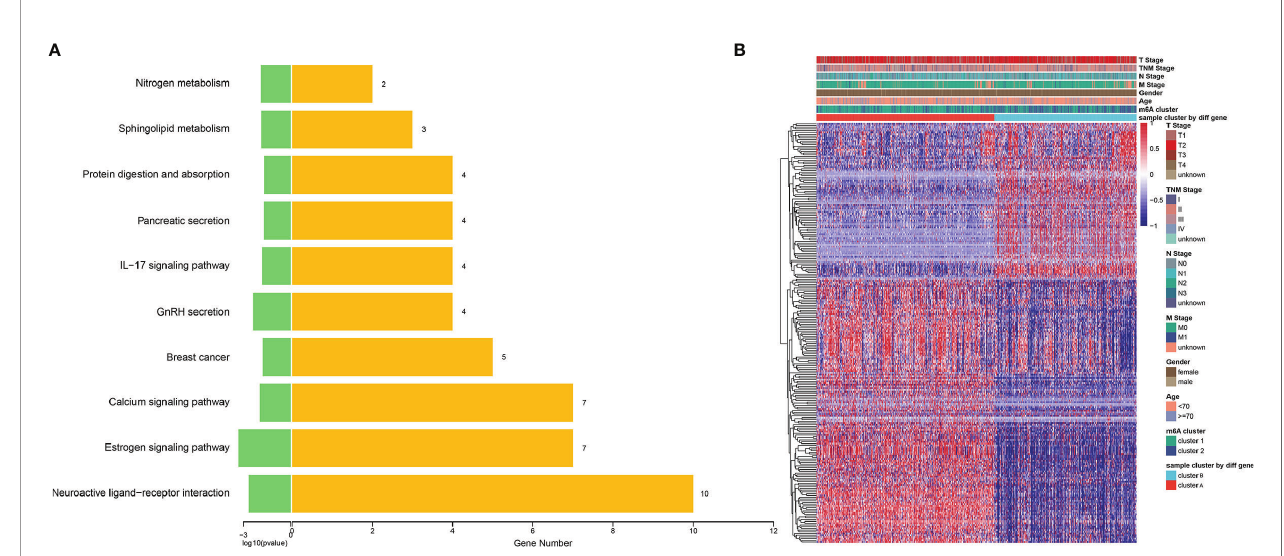
FIGURE 6 | Construction of differential expression of m 6 A gene signatures and functional annotation. (A) Functional annotation for 533 m 6 A-related genes using KEGG pathway analysis. The yellow barplots represented the number of genes enriched; the green barplots represented p-value. (B) Unsupervised clustering of overlapping m 6 A phenotype-related DEGs to classify breast cancer patients into different subtypes, termed as cluster A and B, respectively. The gene signature subtypes, m 6 A clusters, tumor stage, gender, and age were used as patient